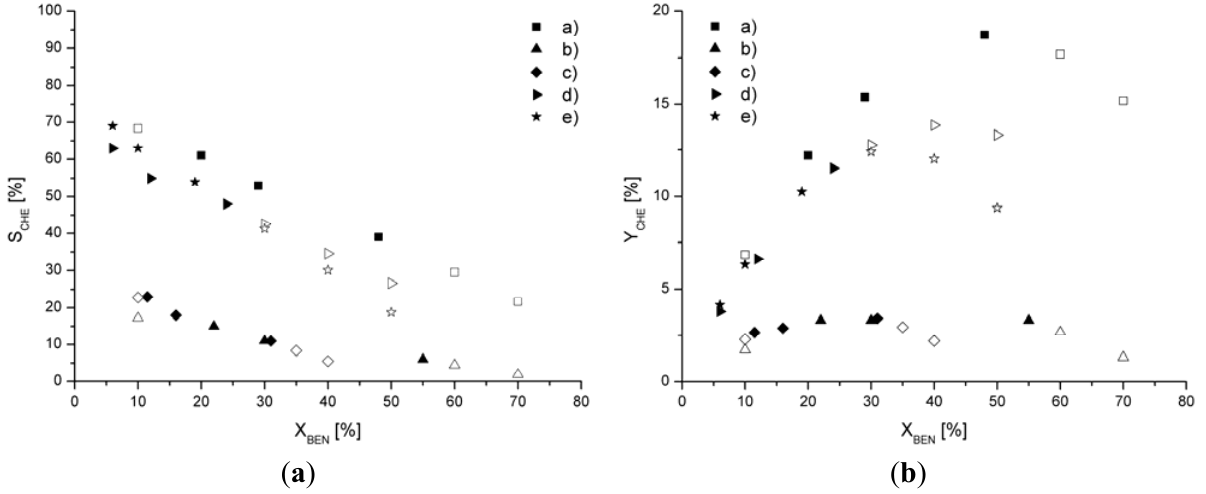
Figure 7. Cyclohexene selectivity ( a ) and yield ( b ) against the conversion of benzene. Blank symbols are fitted data points. (Reaction conditions: 1.5–3 g 2Ru/La 2 O 3 –ZnO and 0.5 g